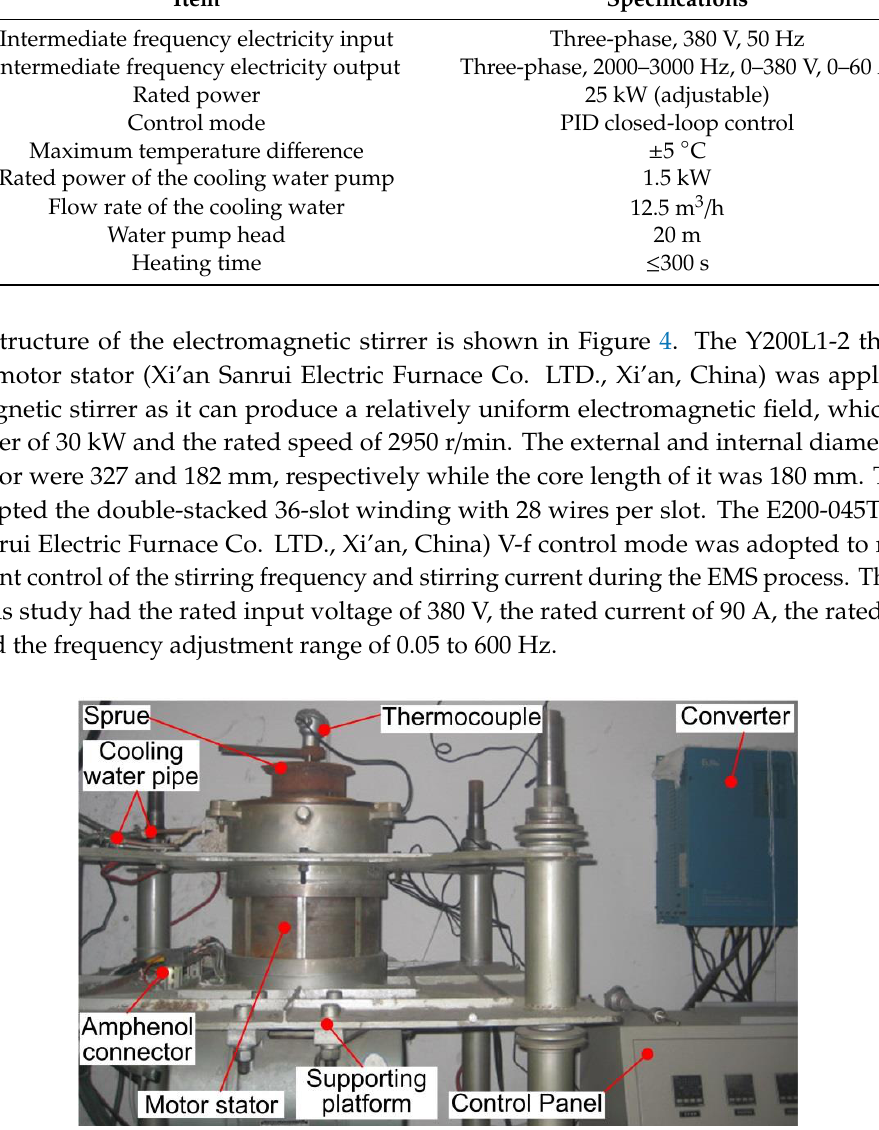
Figure 4. Experimental test rig of the electromagnetic stirrer.